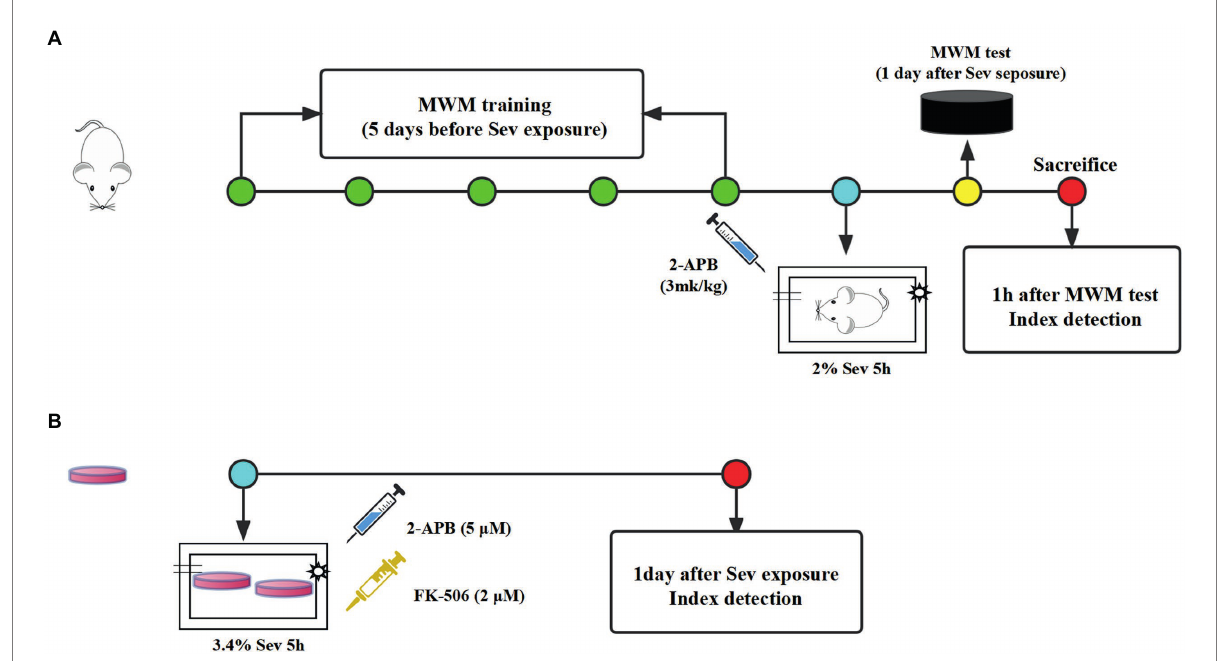
FIGURE1 The experimental schematic diagram. (A) Rats received MWM training once a day for 5 days and were exposed to 3% sevoflurane for 2 h at 1 day after the last MWM training. At 1 day after sevoflurane exposure, MWM tests was established to evaluate cognitive function of aged rats, then 1 h after MWM tests, rats were sacrificed for index detection. (B) All dishes of hippocampal neurons were exposed to 3.4% sevoflurane for 5 h. At 1 day after sevoflurane exposure, all index were detected. MWM, Morris water maze, Sev,